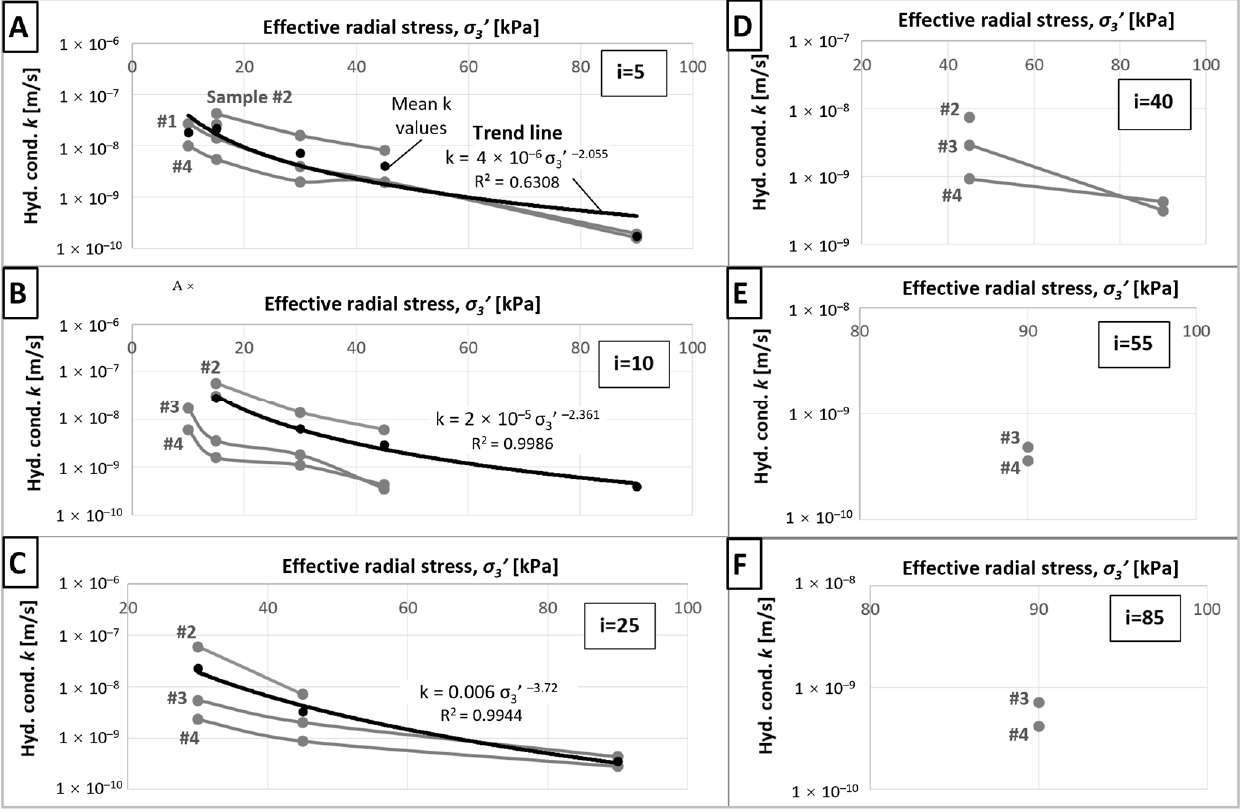
Figure 8. Detail characteristics of k value of peat from the Upper Biebrza Valley in the function of effective radial stress in various hydraulic gradient cases derived from triaxial tests: ( A ) i = 5, ( B ) i = 10, ( C ) i = 25, ( D ) i = 40, ( E ) i = 55, ( F ) i = 85.